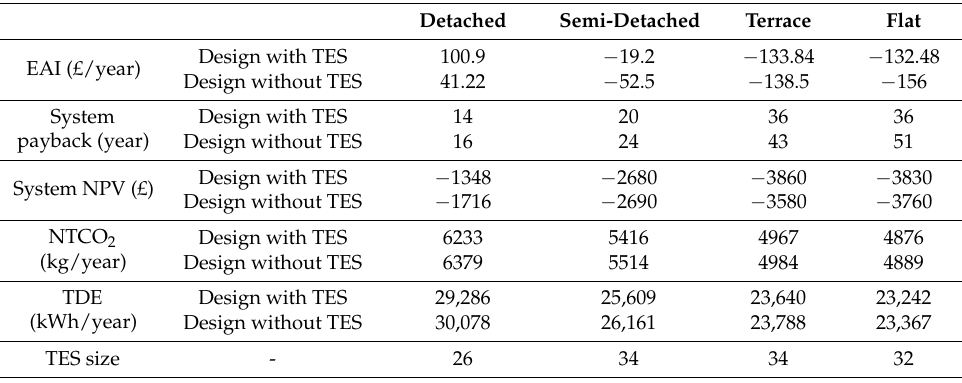
Table 2. Non-incentivised design